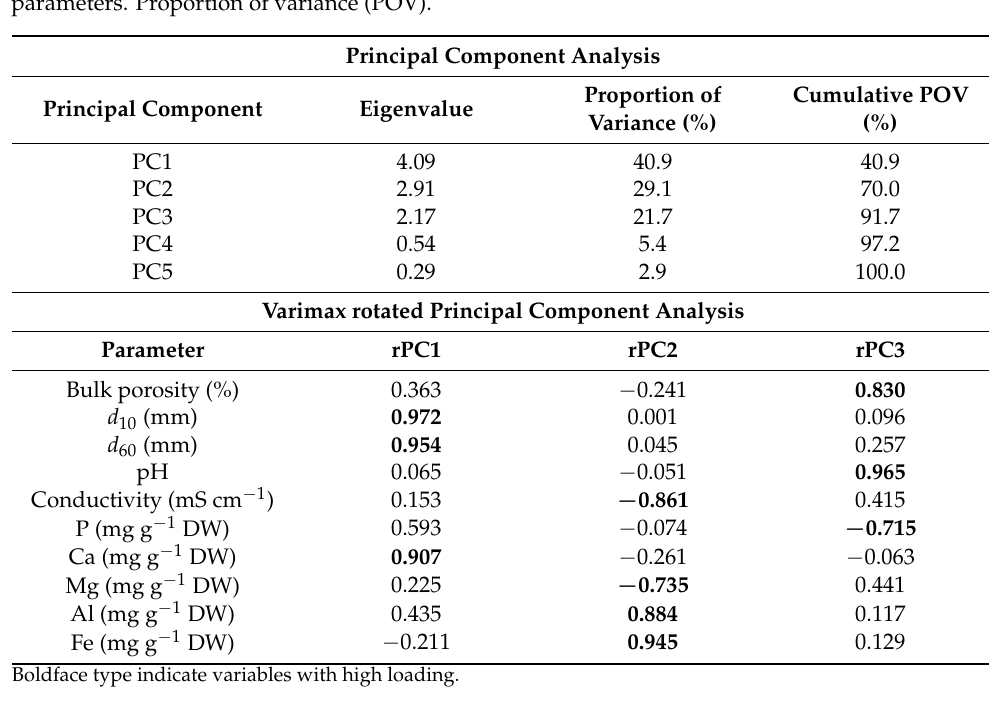
Table 6. Principle Component Analysis (PCA) and Varimax rotated Principal Component Analysis (Varimax rPCA) for the non-coated materials. PCA with eigenvalue, percentage, and cumulative percentage. Varimax rPCA with loadings for the different parameters of the rotated Principal Components (rPC 1, rPC 2, and rPC 3). The analyses were performed on the conductivity, pH, bulk porosity, particle size distribution ( d 10 and d 60 ), and mineral concentrations of Al, P, Fe, Ca, and Mg. Specific weight and uniformity coefficient have been excluded, as they are represented in other parameters. Proportion of variance (POV).